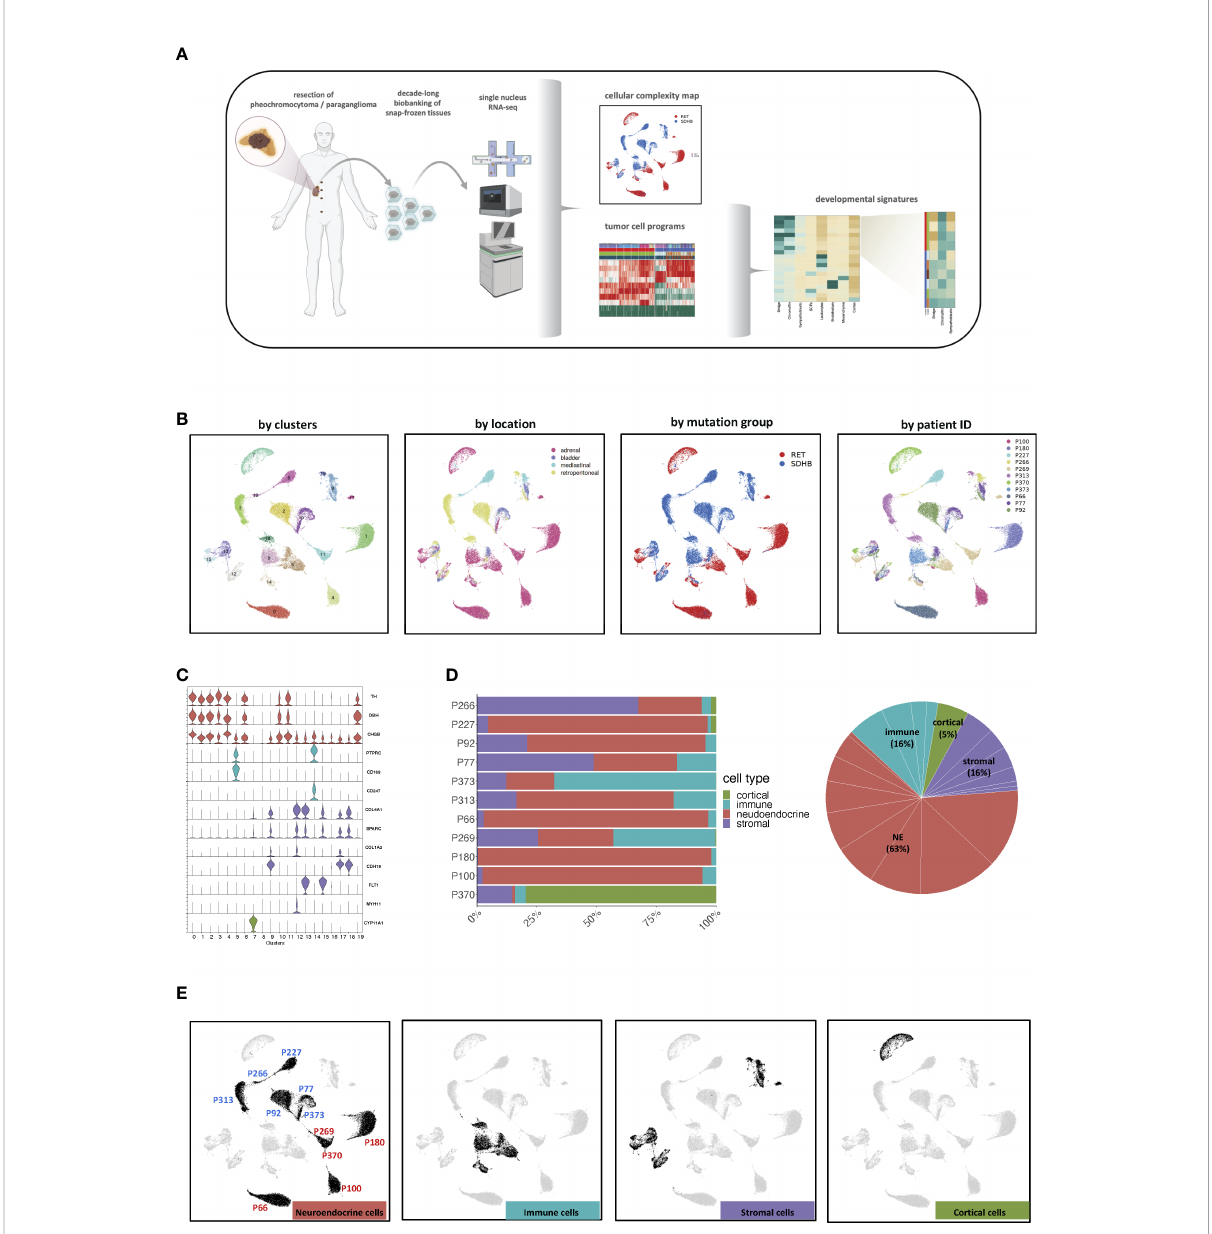
FIGURE 1 (A) Graphical abstract of the study. Created with BioRender.com. (B) UMAP visualization of all 50 868 cells grouped according to their cluster annotation and colored by their clusters, location of origin, mutation group, or patient ID. (C) Violin plots displaying the expression levels of canonical markers of representative cell types. (D) Distribution of cell types across the merged dataset and per sample. (E) UMAP visualization of all 50,868 cells, highlighting the cells annotated as the main cell types. The UMAP clusters of NEs were also marked by their most representative patient